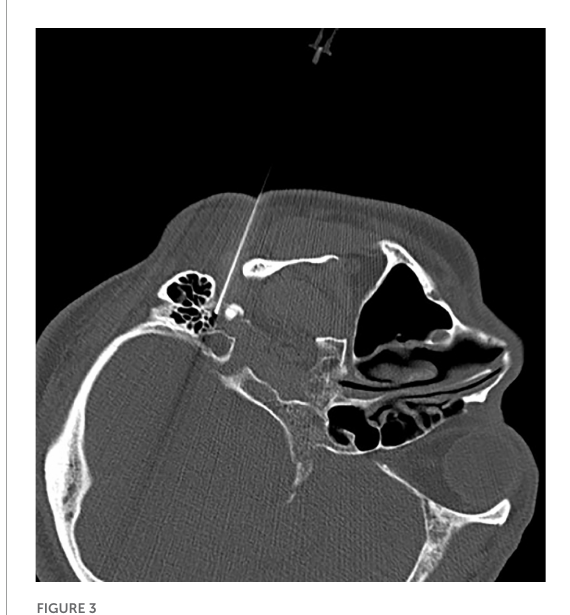
FIGURE3 Puncturing of the stylomastoid foramen under intermittent CT guidance.